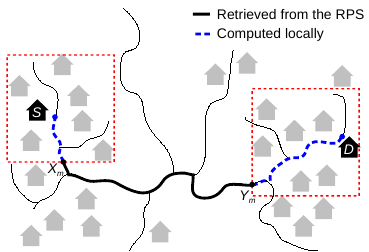
Figure 3: Local path completion within the SZs.